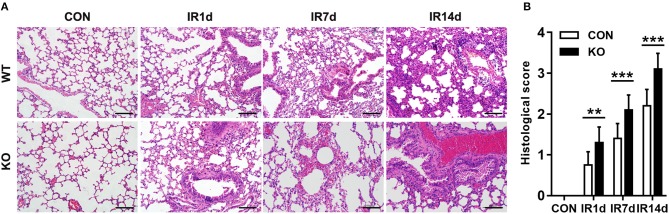
Nrf2 knockout aggravates radiation-induced lung injury. (A) HE staining was used to evaluate IR-induced structural destruction of the lung tissues. Scale bar: 100 μm. The representative figures of 3 independent experiments were presented here. (B) Histology scores of HE staning. n = 6. **P < 0.01; ***P < 0.001.